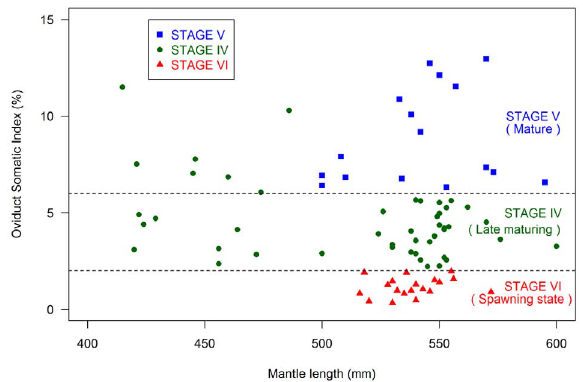
Fig. 2. – Mantle length distribution in relation to the oviduct somatic index and stages of maturity for the female squid Ommastrephes bartramii